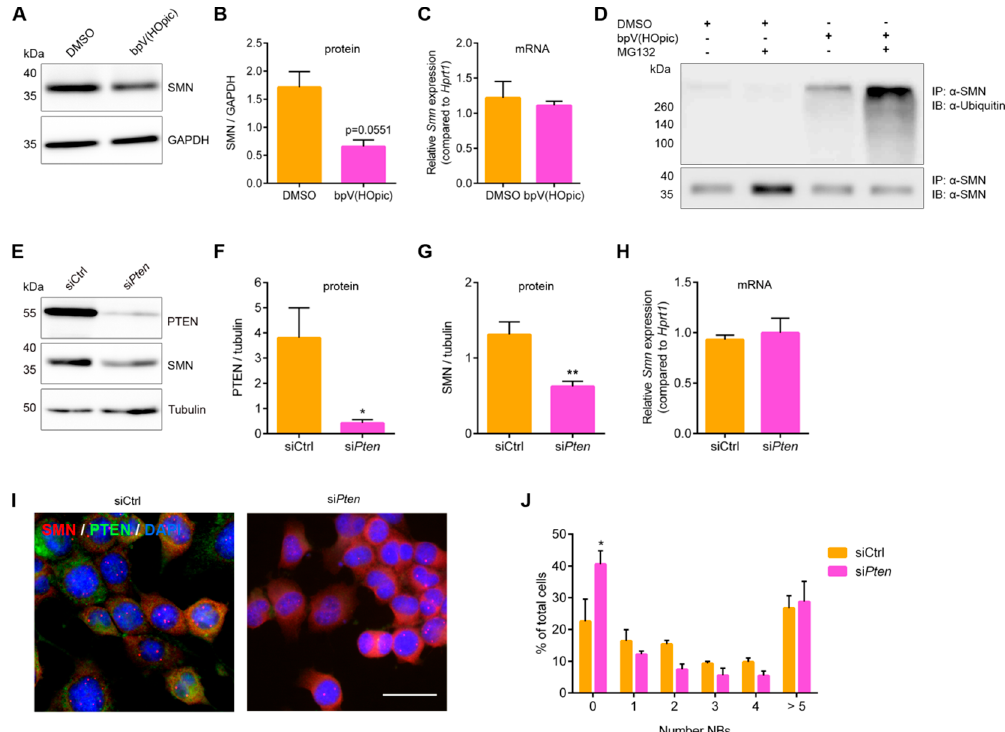
Figure 5. PTEN inhibition and knockdown decrease SMN levels via proteasomal degradation. ( A , B ) NSC34 cells were differentiated and treated with DMSO or PTEN inhibitor bpV(HOpic) for 6 h prior to lysis. Western blot analysis determined SMN protein levels and SMN compared to housekeeping protein was quantified by densitometry (mean ± SEM, n = 5, paired two-tailed t-test, p = 0.0551). ( C ) Relative Smn expression of DMSO- or bpV(HOpic)-treated cells (6 h) was analyzed by qRT-PCR (mean ± SEM, n = 3, paired two-tailed t-test, ns = not significant). ( D ) Cells were differentiated and treated with DMSO or bpV(HOpic) and in the absence or presence of the proteasome inhibitor MG132 for 6 h. SMN ubiquitination was analyzed upon SMN immunoprecipitation. ( E – G ) NSC34 cells were transfected with siRNA for Pten (si Pten ) or control (siCtrl) and differentiated. Western blot analysis determined PTEN and SMN levels ( E ) together with densitometric quantification of PTEN ( F ) and SMN ( G ) compared to housekeeping protein (mean ± SEM, n = 5, paired two-tailed t-test, * p < 0.05, ** p < 0.01). ( H ) Relative Smn expression in control or PTEN-depleted cells analyzed by qRT-PCR (mean ± SEM, n = 3, paired two-tailed t-test, ns). ( I , J ) Quantification of SMN-positive nuclear bodies (NBs) of control or PTEN-depleted cells (mean ± SEM, n = 3, multiple t-test, * p < 0.05).